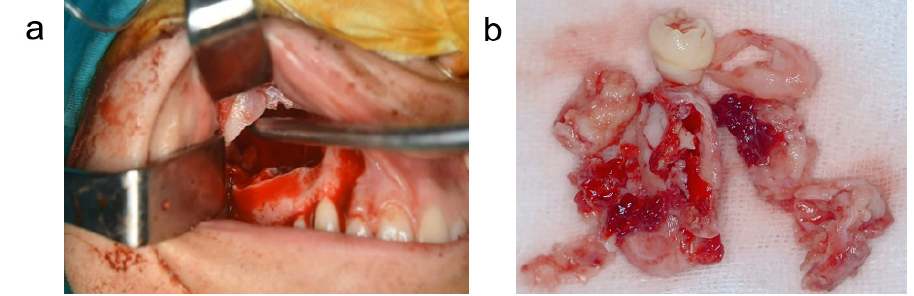
Figure 3. ( a ) Perioperative image showing the bony window created in the anterior wall of the sinus. ( b ) Underdeveloped ectopic molar with cystic lining.